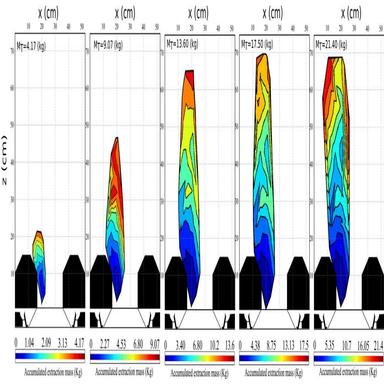
Evolution of the ellipse to different accumulated extraction mass with 4% moisture content - isolated draw - longitudinal view to the drawbell.